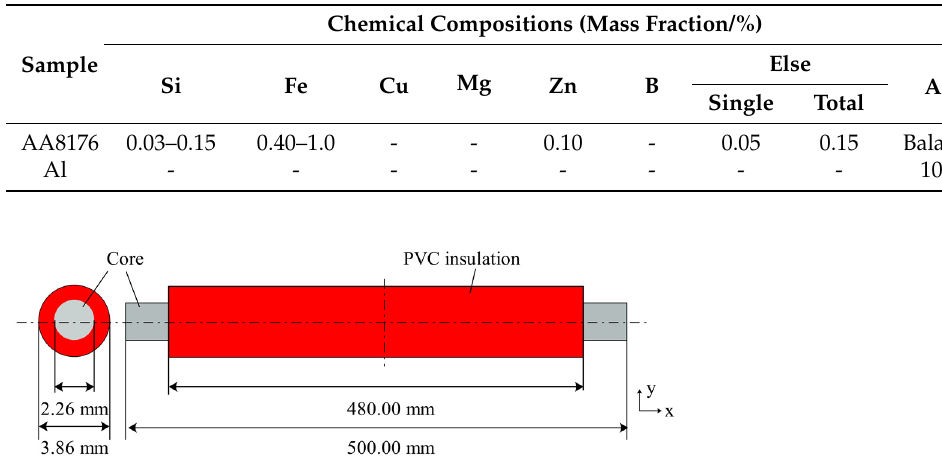
Figure 2. Wire configuration (mm).